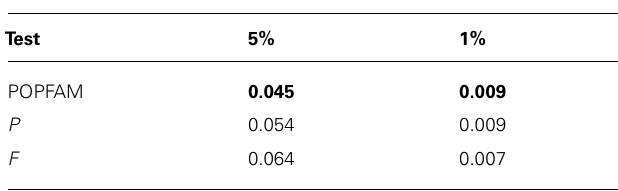
Table 2 |Type I error of POPFAM, P and